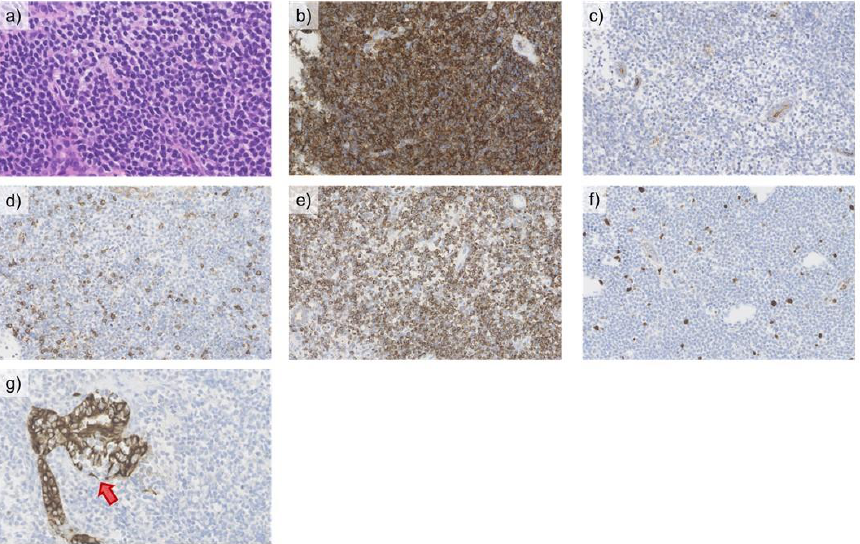
Figure 5. A punched biopsy of the segment S8 tumor lesion revealed the infiltration of small atypical lymphoid cells ( a ) (hematoxylin and eosin staining, × 400 magnification), which were CD20+ ( b ), CD10- ( c ), CD5- ( d ), and Bcl2+ ( e ) by immunohistochemistry ( × 200 magnification). The Ki-67 labeling index was calculated as approximately 5% ( × 200 magnification) ( f ). Cytokeratin (AE1/AE3) was stained on the lymphoepithelial lesions ( g , arrow) ( × 200 magnification).